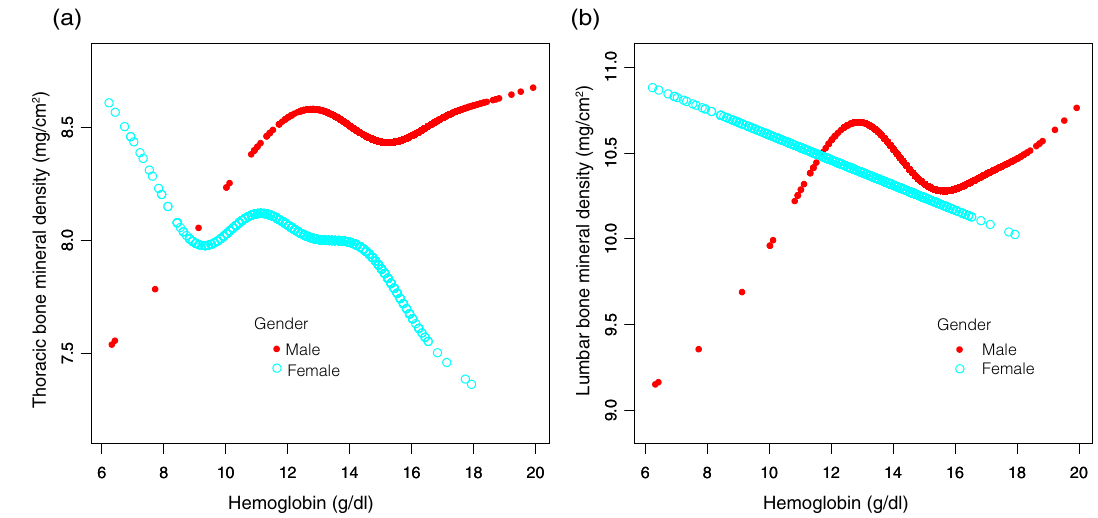
Figure 4. The hemoglobin and bone mineral density relationship, stratified by gender. Age, race, annual household income, education level, SBP, DBP, BMI, red blood cell count, albumin, ALP, ALT, blood urea nitrogen, total calcium, iron, CPK, creatinine, glucose, LDH, phosphorus, total bilirubin, total protein, uric acid, albumin creatinine ratio, blood cadmium, blood lead, phosphorus, potassium, triglyceride, LDL-C, HDL-C, total cholesterol, alcohol status, smoking status and diabetes were adjusted. ( a ) Thoracic BMD; ( b ) Lumbar BMD. Red line: Male; Blue line: Female.